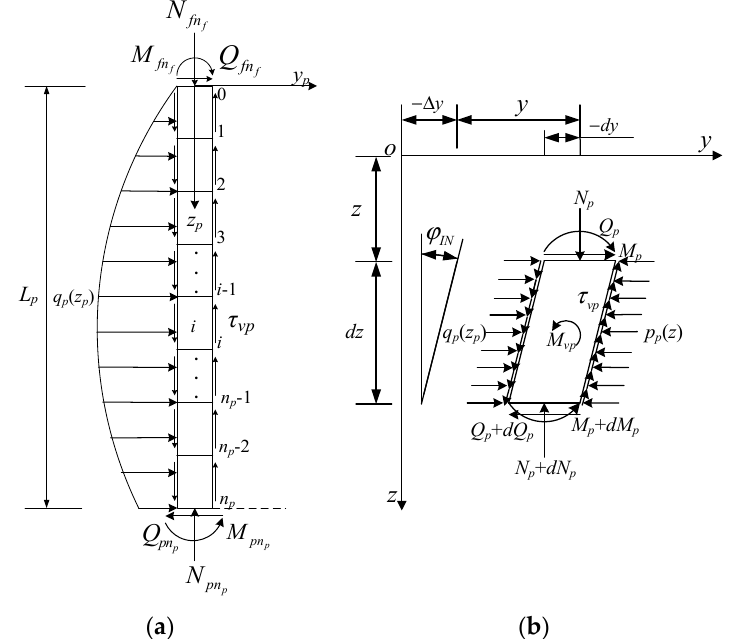
Figure 5. Discretization of passive segment and element analysis for a segment. ( a ) Discretization of passive segment. ( b ) Element analysis for a segment.